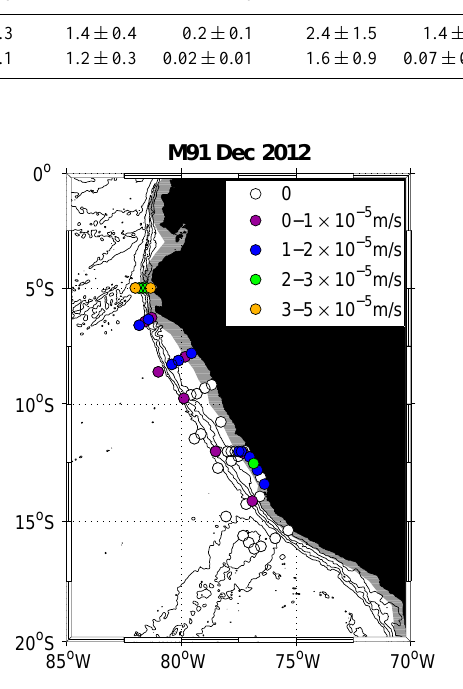
Table 2. Mean upwelling velocities w . M91 M68/3 P347 ATA3 coastal coastal surf. offshore coastal offshore coastal offshore coastal offshore